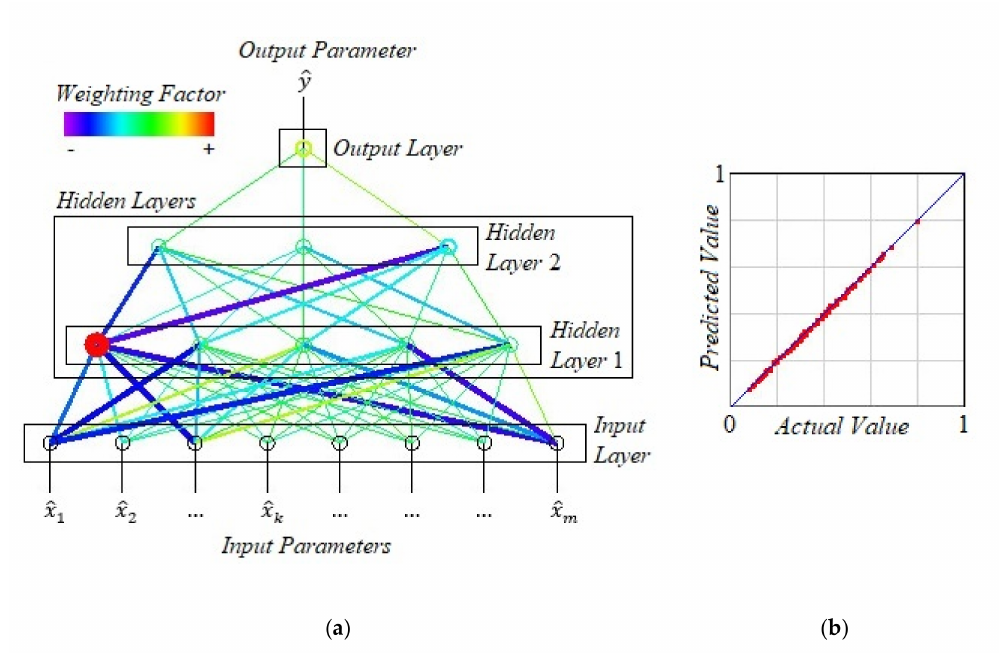
Figure 1. Artificial neural network architecture ( a ) and convergence of the regression procedure ( b